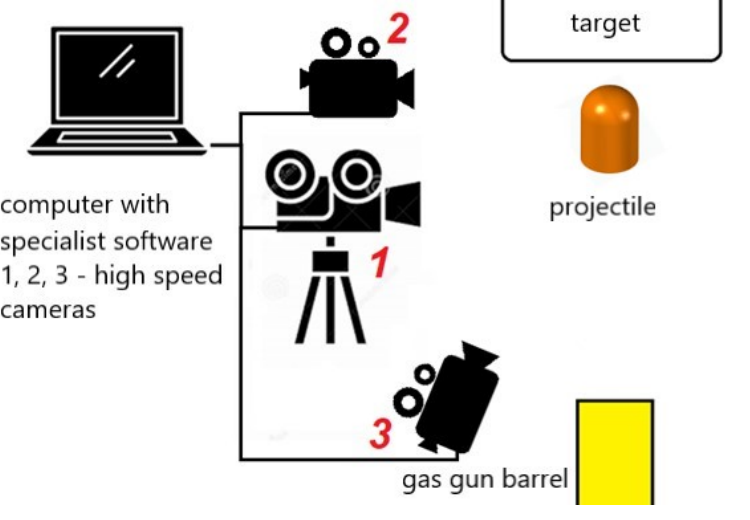
Figure 8. Experimental setup elements.